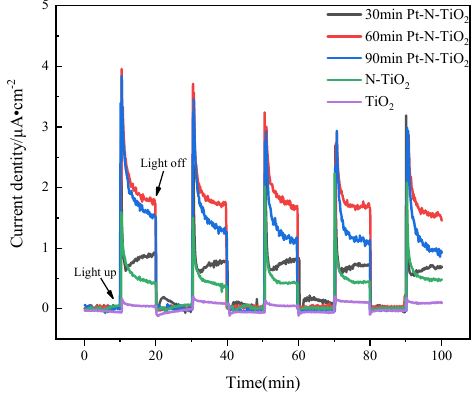
Figure 7. I ‐ t pattern of each nanotube. Figure 7. I-t pattern of each